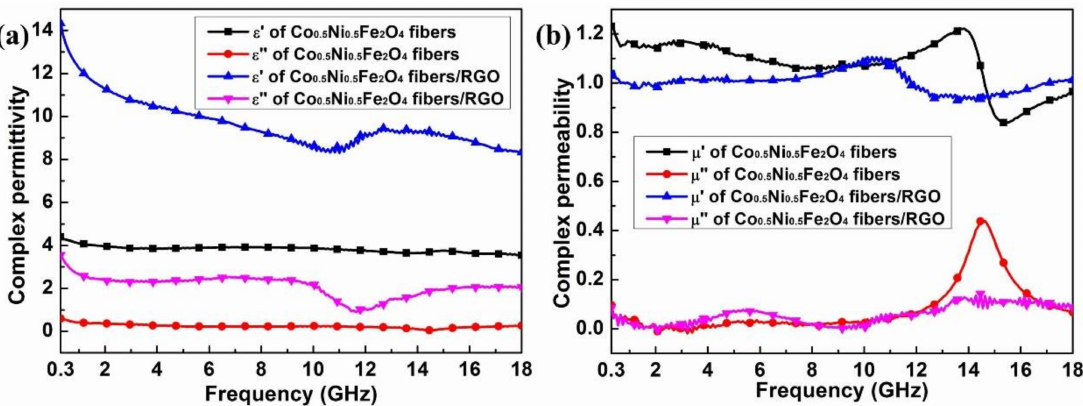
Figure 4. Frequency dependence of the relative complex electromagnetic parameters spectra: ( a ) Complex permittivity; ( b ) Complex